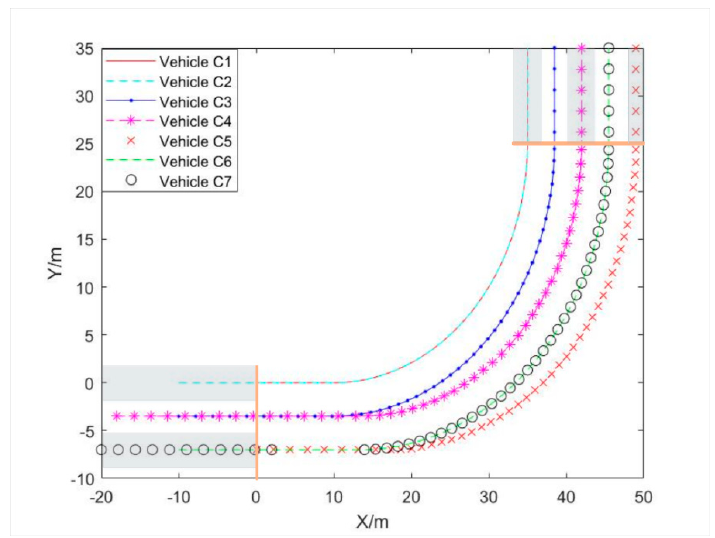
Figure 5. Track coordinates of all seven vehicles.